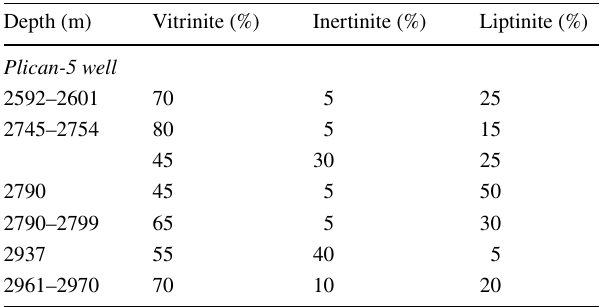
Table 6 Maceral composition (vitrinite, inertinite and liptinite) data for the Narimba Formation in Pelican-5 well Depth (m)